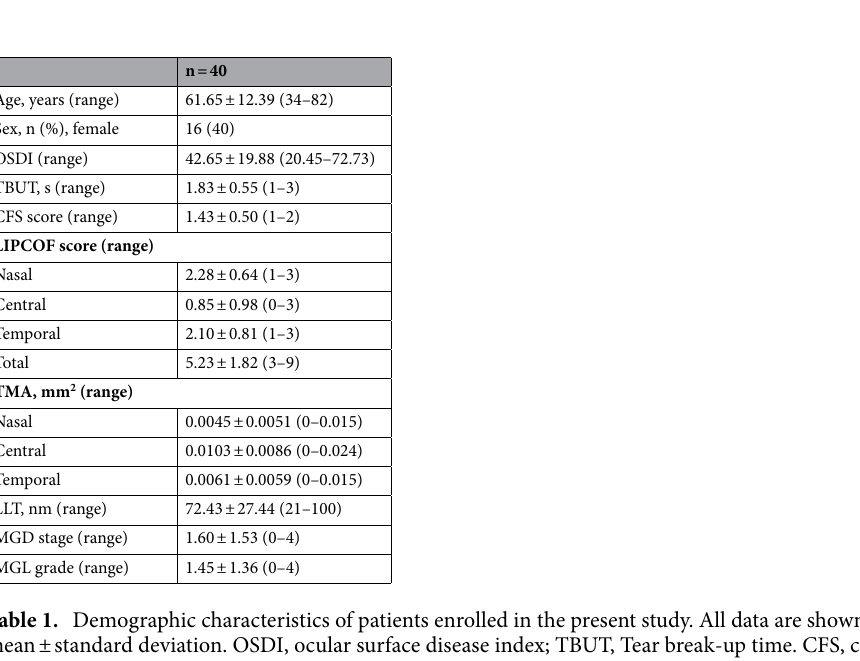
Figure 1. Consecutive photographs of high-frequency radiowave electrosurgery for conjunctivochalasis. ( a ) After instillation of 0.5% proparacaine, the extent of the conjunctivochalasis (CCh) was determined using a cotton tip. ( b – d ) Using a fine insulated coated needle of the 4.0-MHz radiowave system, ablation of CCh was consecutively performed at the temporal, inferior, and nasal bulbar conjunctiva, causing a gradual change of the conjunctiva to a dusky white color (blanching) while lifting to prevent the sclera from thermal burns. ( e ) Ablation was also continued at the conjunctival fornix. ( f ) Finally, complete elimination of CCh was confirmed using a cotton tip.